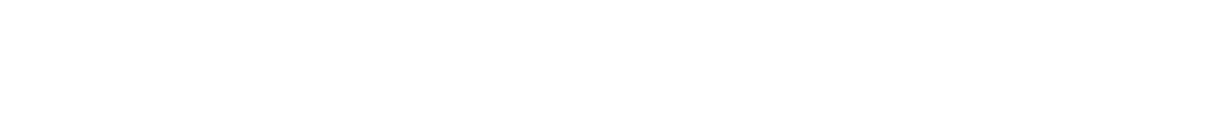
FIGURE 5 | Rarefied phylogenetic diversity profile, q D Z ( π ), for (A) the young mat sample, (B) the old mat 2010 sample, and (C) the old mat 2011 sample. Increasing parameter q decreases the metric’s sensitivity to rare taxa and becomes a measure of evenness. Inset box shows values 2 ≤ q ≤